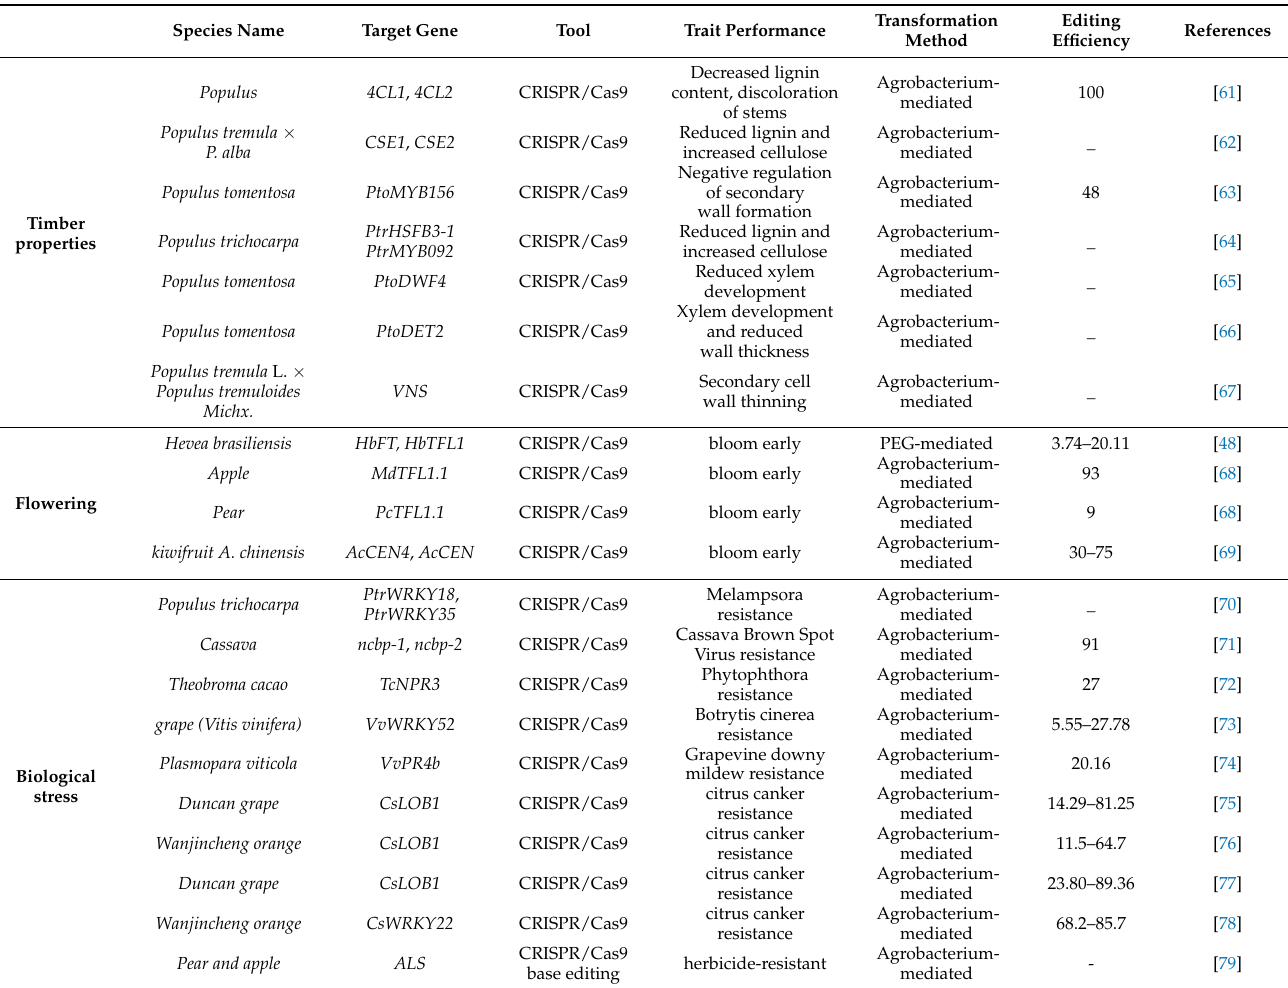
Table 1. Application of CRISPR/Cas system in woody